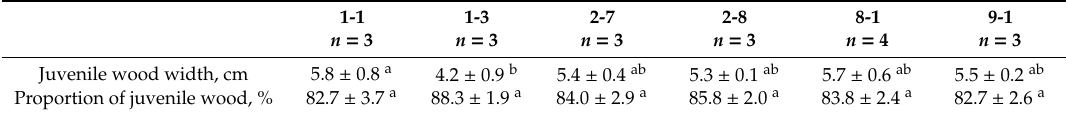
Table 3. Means and standard deviations (SD) in six C. bungei clones.